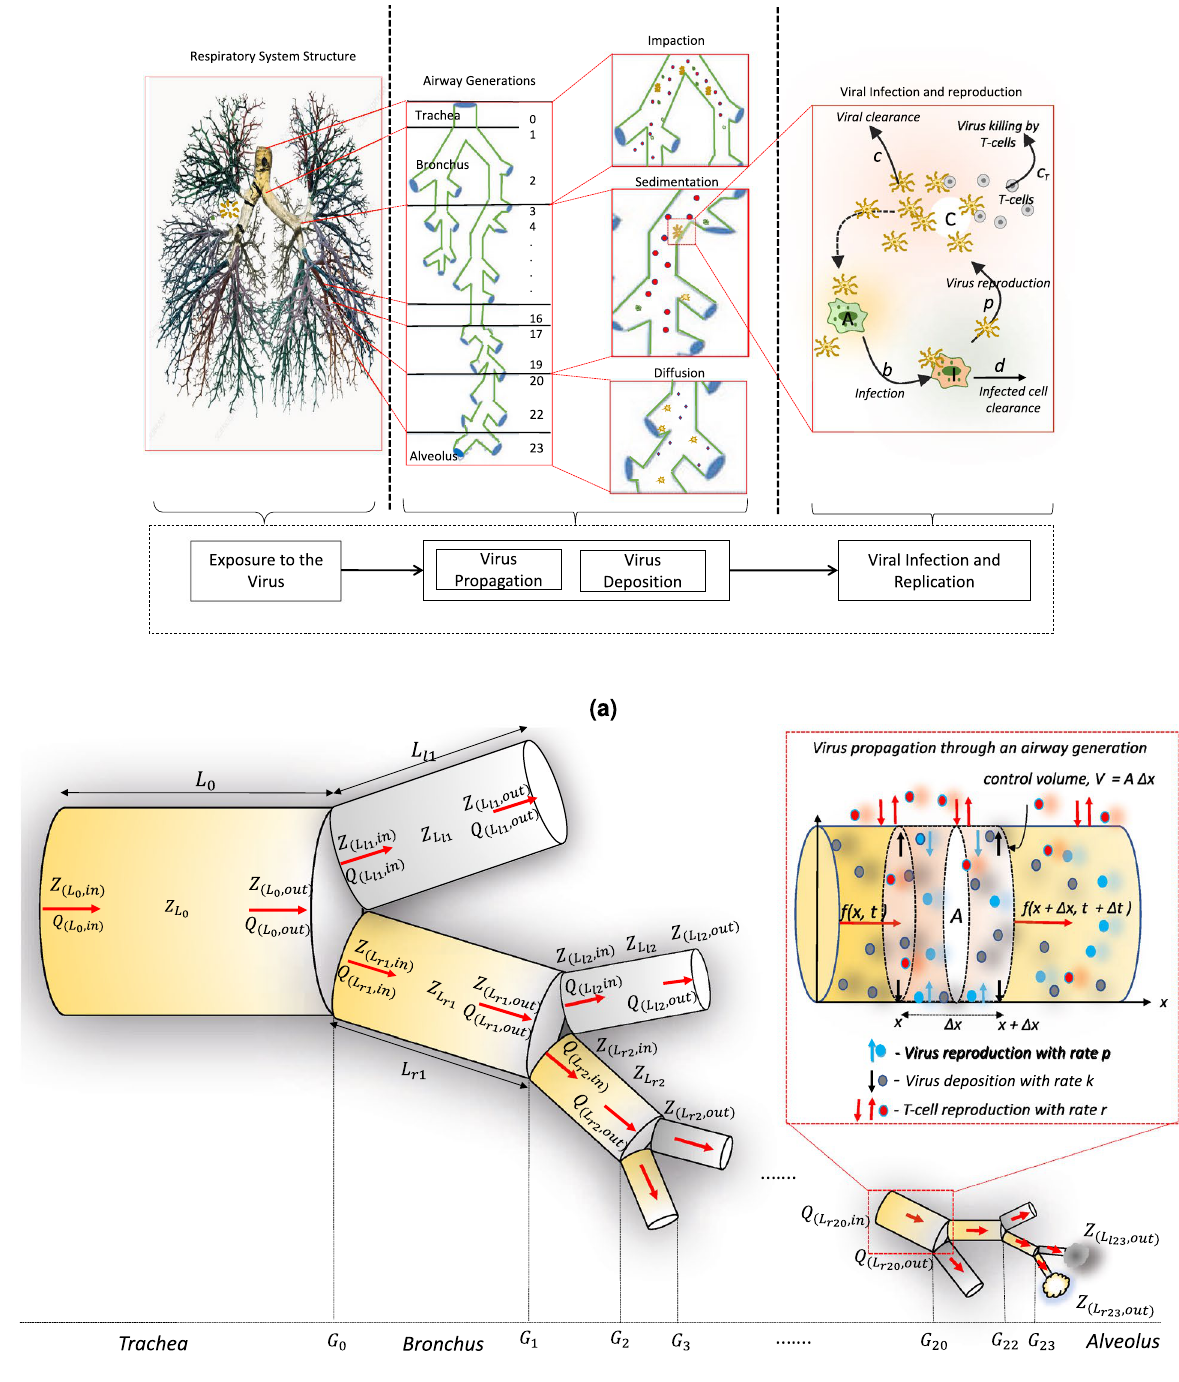
Figure 1. An overview of the computational modeling approach; ( a ) computational model for exploring the temporal viral propagation dynamics down the branch generation of the respiratory tract considering the virus propagation, deposition, and infection dynamics along the airway tract and ( b ) bifurcation of the respiratory (left - l branch and right - r branch) airways. The subscript notation in and out are used to denote the inlet and outlet pressure ( P ), airflow rate ( Q ) and impedance ( Z ) in each airway and virus particle propagation through a control volume of an airway with deposition rate k and reproduction rate p (this image was created by using Microsoft PowerPoint version 16.57 and can be accessed